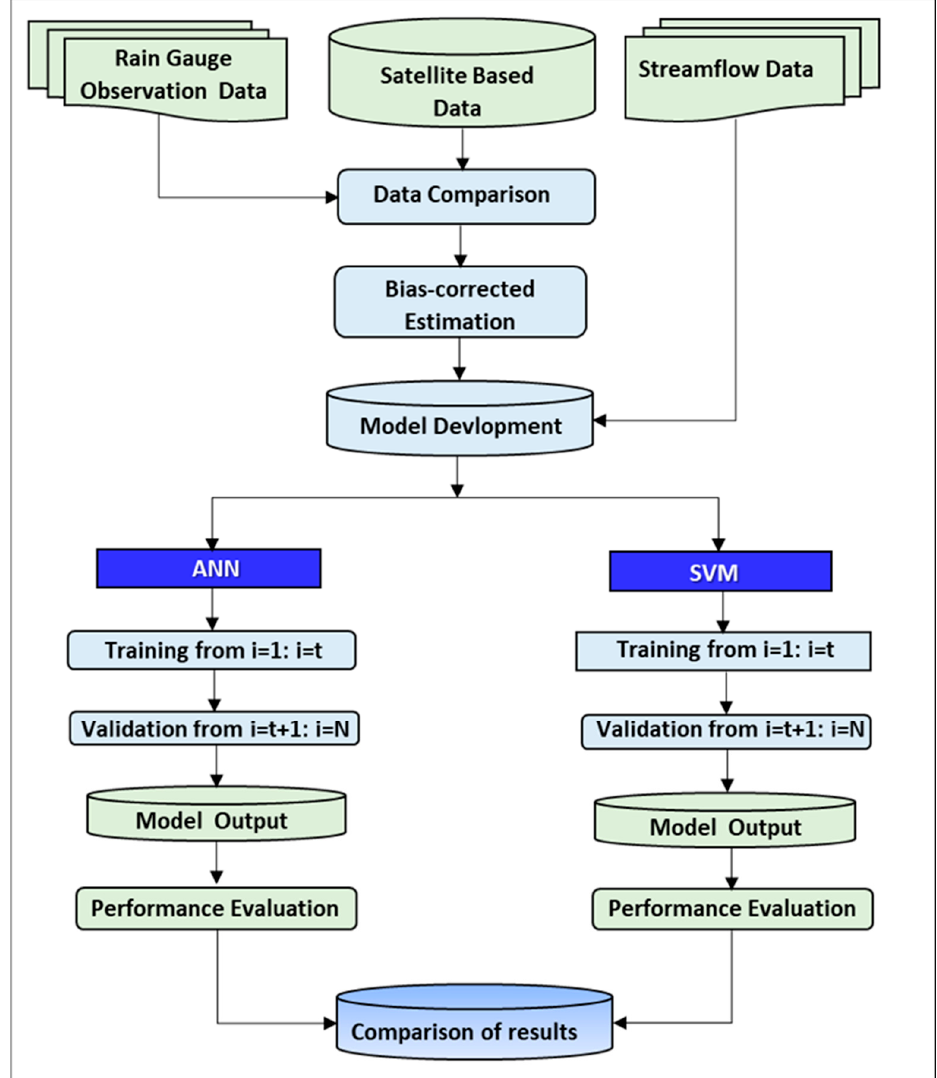
Figure 2. Methodological framework to forecast monthly streamflow.